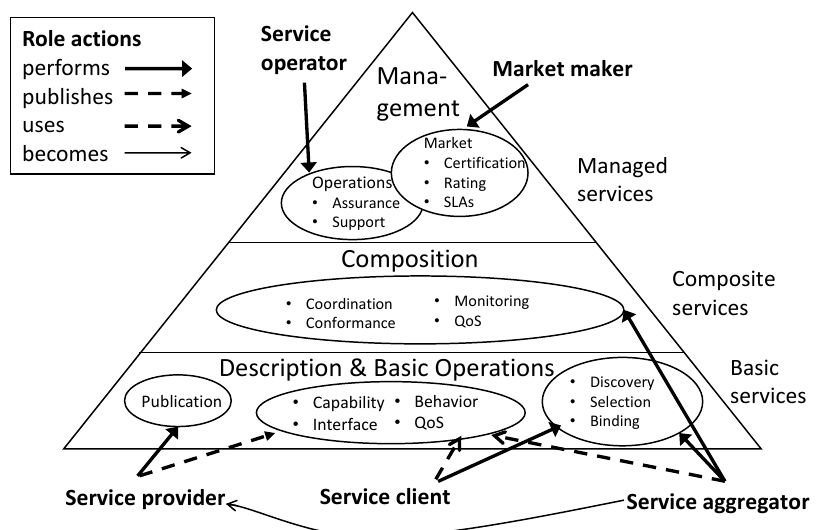
Figure 4. The extended service-oriented architecture emphasizing main research topics (adapted from [11] with permission).